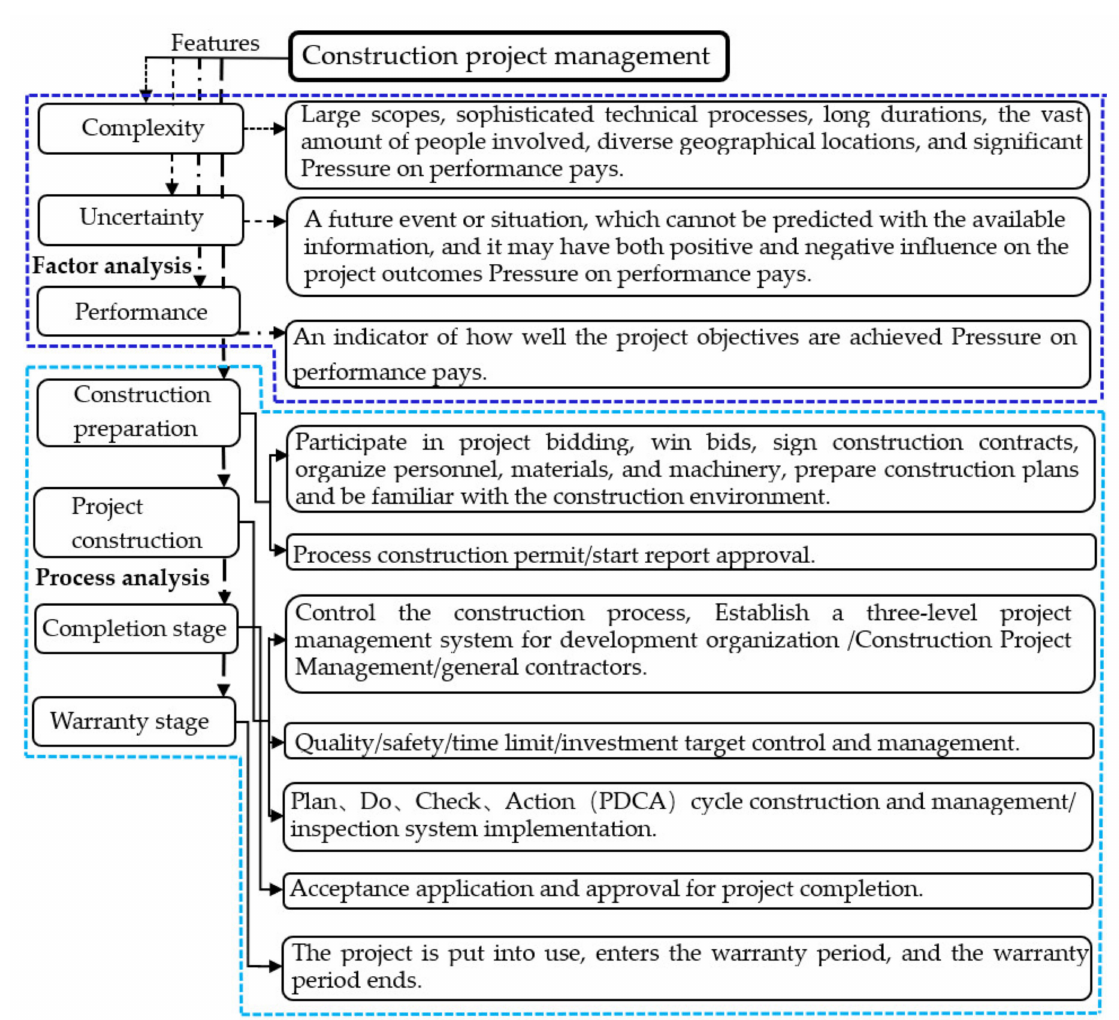
Figure 5. Construction project management factors and process analysis diagram